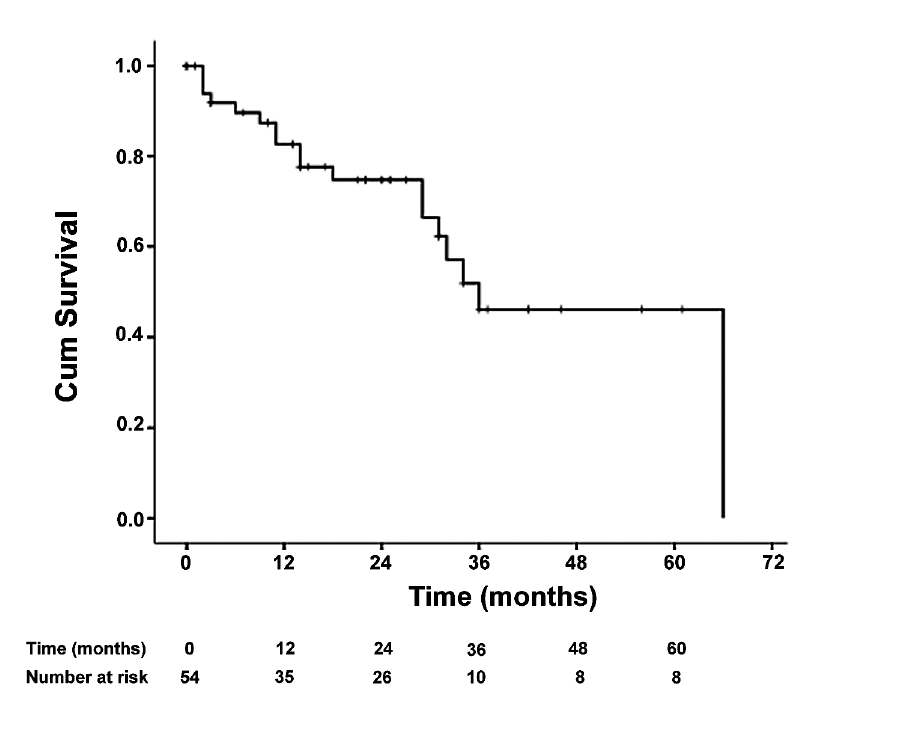
Figure 2 – Overall survival from initiation of complete androgen